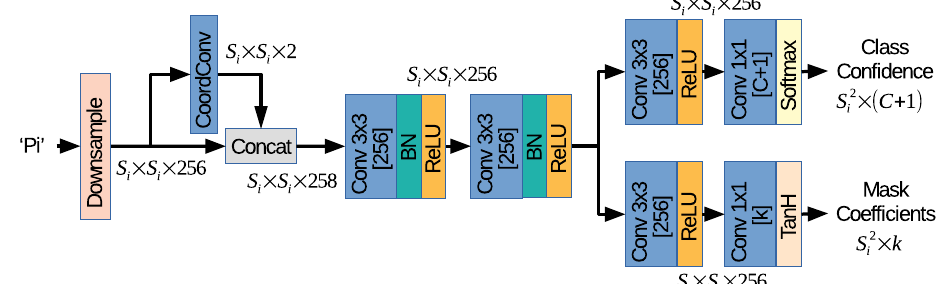
Figure 4. Proposed object detection head